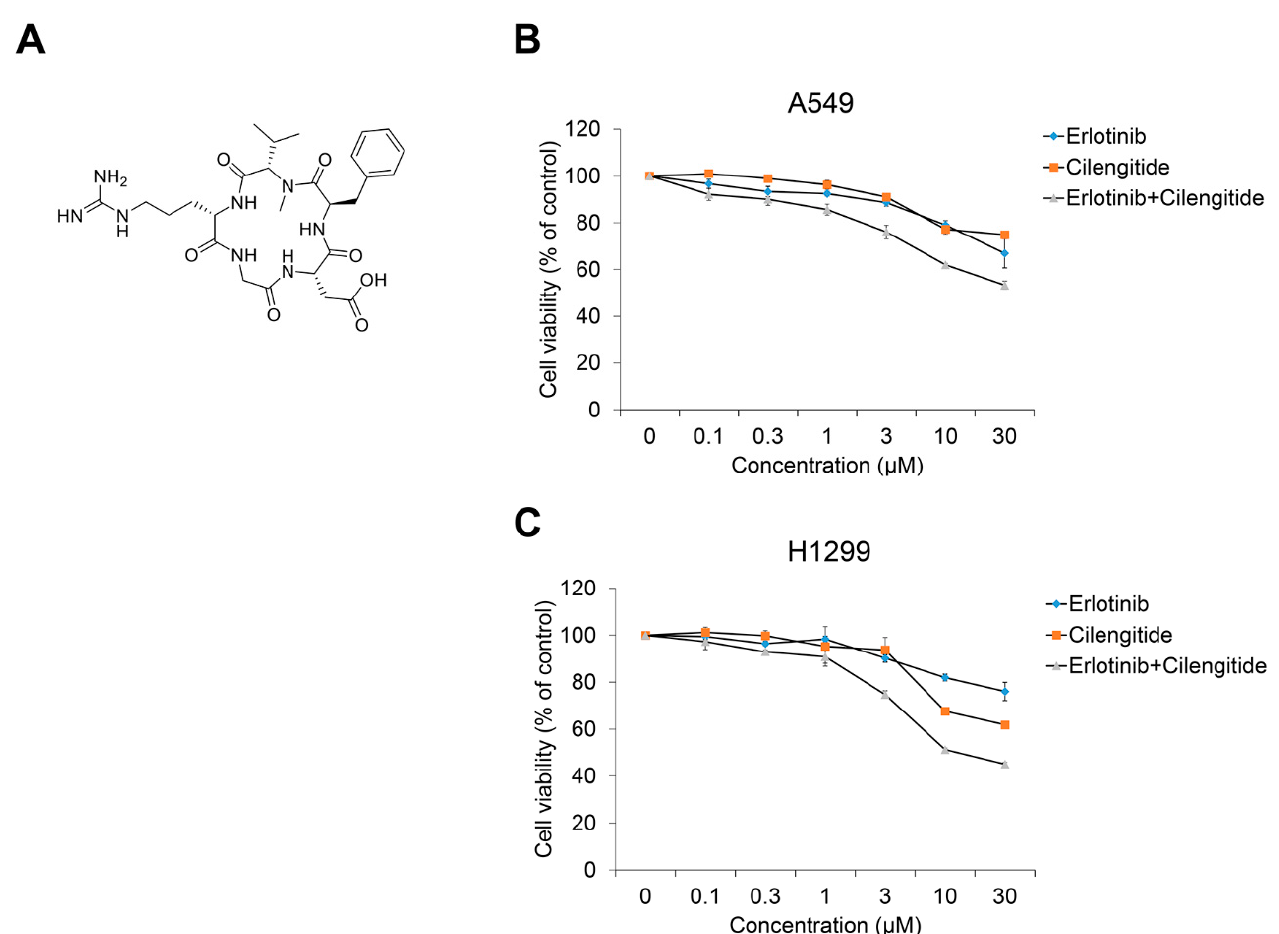
Figure 4. Cilengitide enhances the inhibitory effect of erlotinib on the cell viability of A549 and H1299 cells. ( A ) Chemical structure of cilengitide. ( B ) A549 and ( C ) H1299 cells were treated with erlotinib alone or with cilengitide for 24–72 h. After incubation, cell viability was measured by the CCK-8 assay. Experiments were performed in triplicate. Data represent mean ± SD. Table 1. Combination index (CI) values for the two-drug combination against A549 and H1299 cell viability.